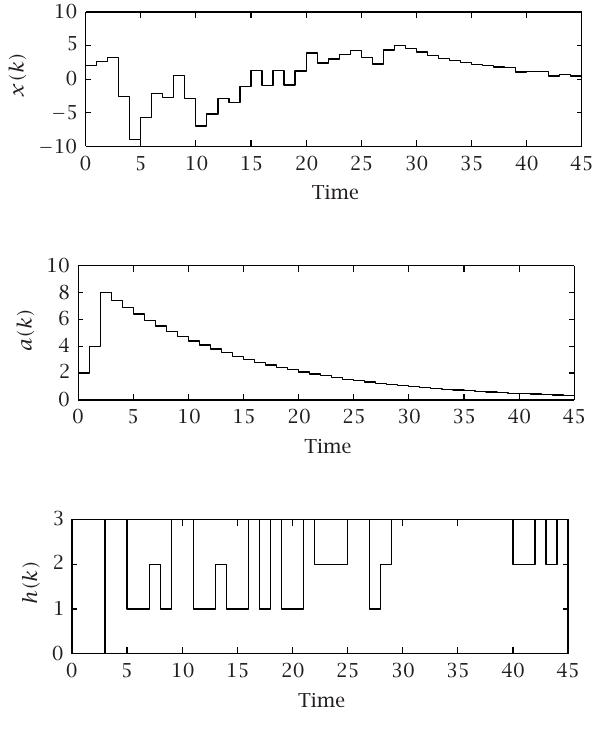
Figure 4.1. Simulation